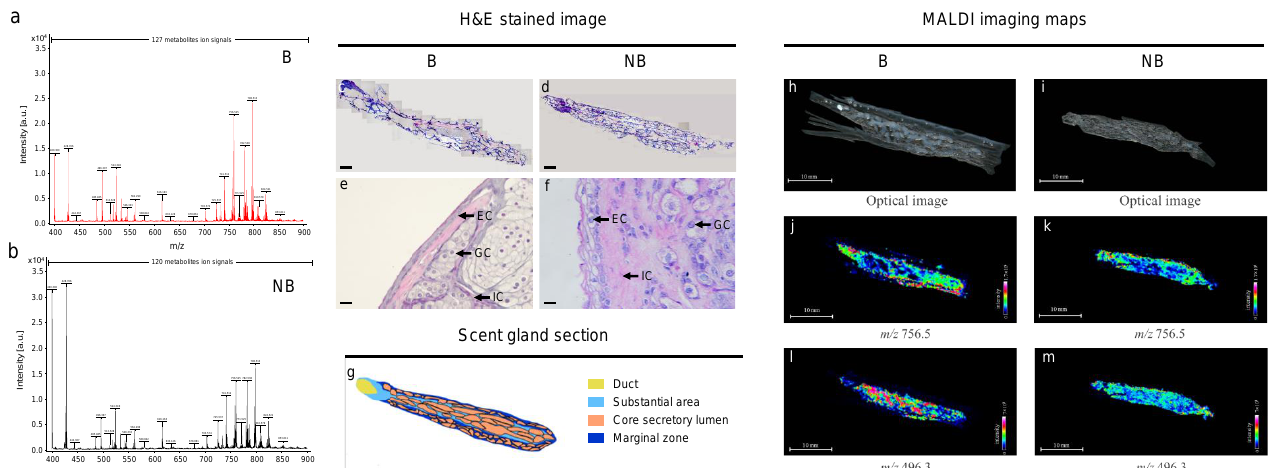
Figure 4. In situ detection and imaging of different metabolites from scent glands of muskrats during the breeding season and the non-breeding season by MALDI-TOF MS in the positive ion mode. ( a , b ) The total ion current obtained for the whole tissue sections by MALDI-TOF MS in the positive ion mode during the breeding and non-breeding seasons. ( c – f ) Histological observation of the scent glands during the breeding and non-breeding seasons. ( g ) Diagram of the scent glands based on histological structure, including duct, substantial area, core secretory lumen and marginal zone. ( h , i ) The 20 µ m tissue sections of the scent glands by MALDI-TOF MS in the positive ion mode during the breeding and non-breeding seasons. ( j , k , l , m ) MALDI-TOF MS imaging maps of the ion at m/z 756.5 and m/z 496.3 detected in the scent glands during breeding and non-breeding seasons. B, the breeding season; NB, the non-breeding